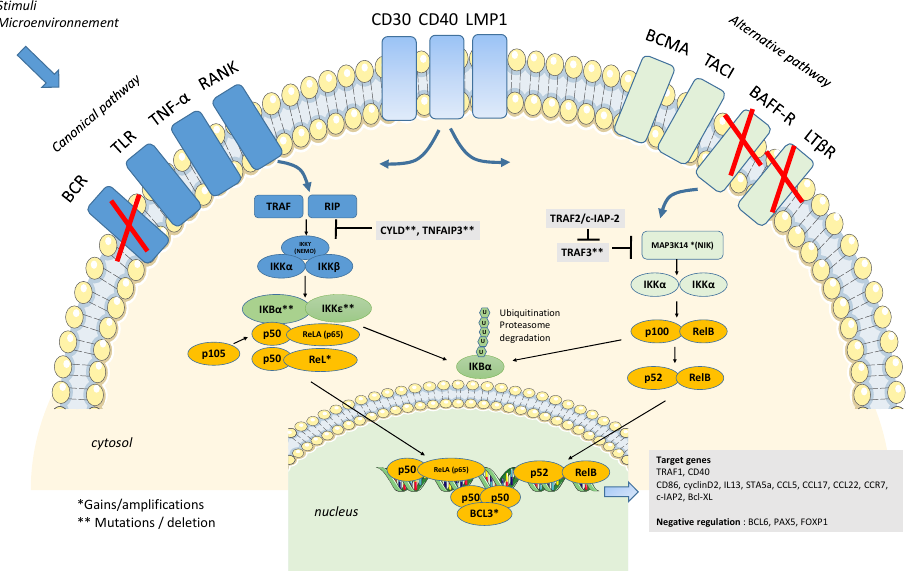
Figure 2. Schematic view of the involvement of the canonical and alternative NFkB pathways in classical Hodgkin lymphoma pathogenesis. The canonical and noncanonical NF-KB pathways are activated in HRS cells by several TNF receptors, except BCR, BAFF-R, and LTB-R, which are not expressed by these cells. CD30, CD40, and LMP1 are able to activate both alternative and canonical pathways. Following receptor activation, TNF receptor-associated factors (TRAFs) interact with the IKK complex or NIK in the canonical and alternative pathways, respectively. This activation leads to the ubiquitination of the inhibitors IKB α and IKB ε and their destruction by the proteasome. Transcription factor heterodimers (p50-p65, p52-RelB, p50-p50) are then released and translocated to the nucleus to regulate NFkB target genes (including genes positively or negatively regulated). Negative (A20, CYLD, TRAF3, and IKB α / ε ) and positive regulators (Rel, MAP3K14, and BCL3) of the pathways can be targeted by genetic alterations (*/**) in 50% of cHL cases. BCR, BAFF-R and LT β R receptors are usually not expressed by HRS cells. Figure build using Servier Medical Art.